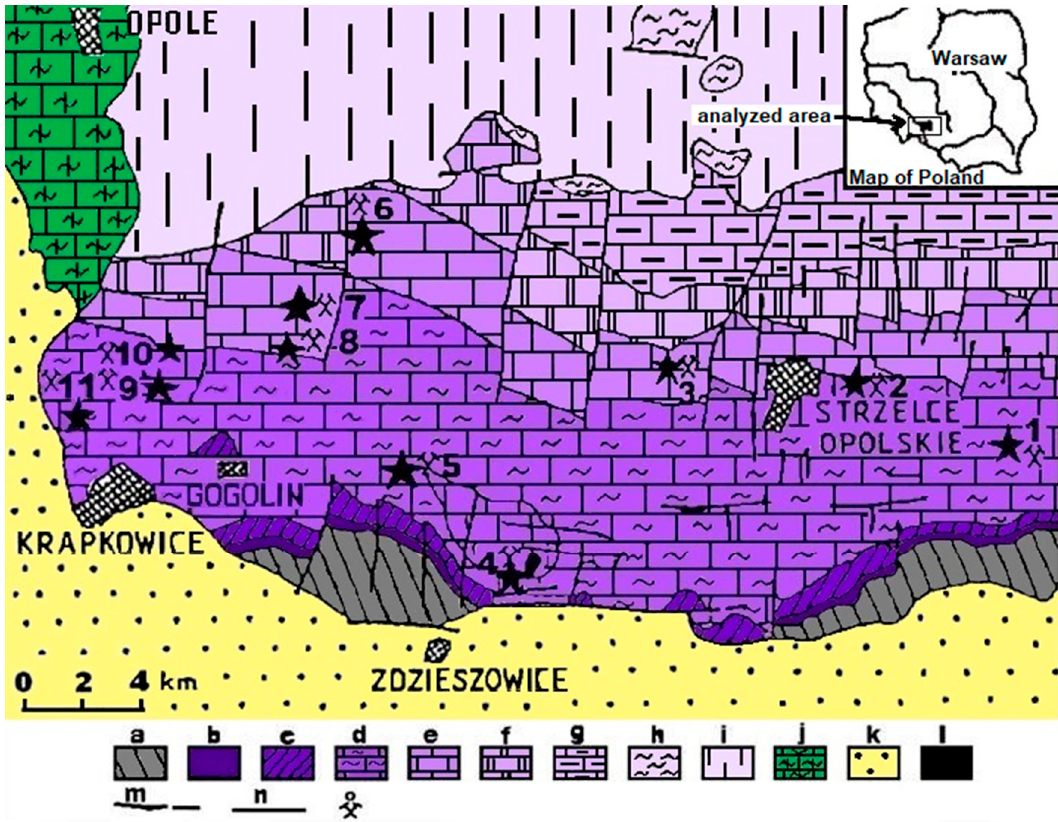
Figure 1. Geological simplified map of the central area of Opole Silesia, according to Nied ź wiedzki [33], modified by Stanienda [21]. a—Lower Carboniferous (greywackes); b—Middle Buntsandstein (sandstones and mudstones); c—Upper Buntstandstein (Roethian) (limestones, dolomites and marls); d—Gogolin Beds (limestones and marls); e—Góra ż d ż e Beds (limestones), Terebratula Beds and Karchowice Beds (limestones); f—Jemielnice Beds (dolomites); g—Rybna Beds and Boruszowice Beds (limestones and dolomites); h—Keuper (claystones, mudstones and sandstones); i—Rhaetian (claystones); j—Upper Cretaceous (sandstones, marls and limestones); k—Neogene (sandstones, clays and gravels); l—Tertiary (basalts); m—faults; n—stratigraphic boundaries; o—important quarries: 1–11—quarries and outcrops: 1—Błotnica Strzelecka; 2—Dziewkowice; 3—Szymiszów; 4—Góra Ś w. Anny and Wysoka; 5—Ligota Dolna and Kamienna; 6—Tarnów Opolski; 7—Kamie ń Ś l ą ski; 8—Góra ż d ż e and Kamionek; 9—Malnia; 10—Chorula; 11—Rogów Opolski areas of sam- pling.